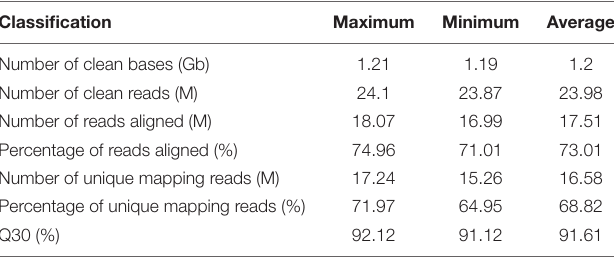
TABLE 1 | Statistical results of the RNA-Seq